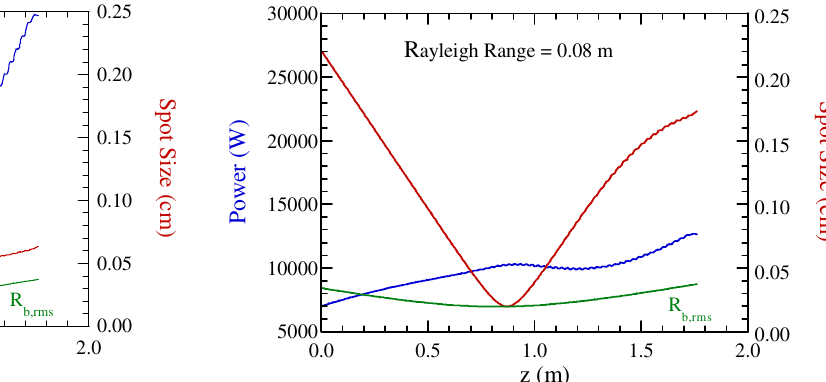
FIG. 8. (Color) Evolution of the power (blue), optical spot size (red), and rms beam radius (green) for a Rayleigh range of 0.5 m that yields optimal